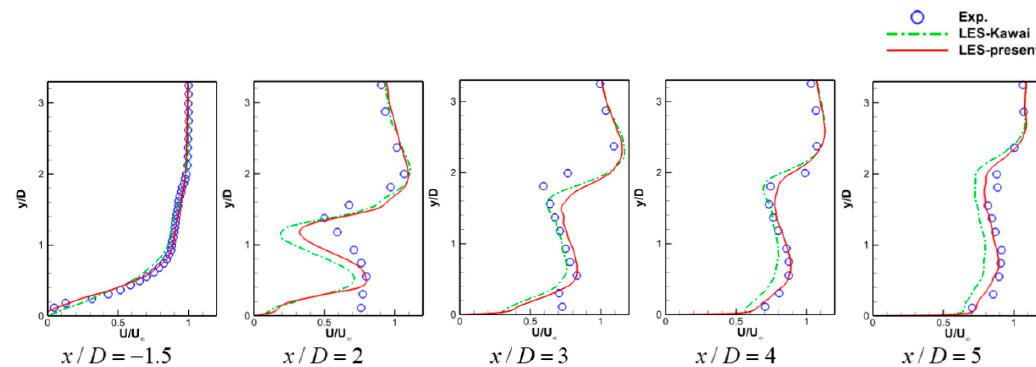
Figure 2. Comparisons of the mean streamwise velocity U / U ∞ profiles between the LES and the experimental data at x / D = − 1.5, 2, 3, 4, and 5; solid lines: LES, dotted line: Kawai’s LES, circle symbols: Experimental.